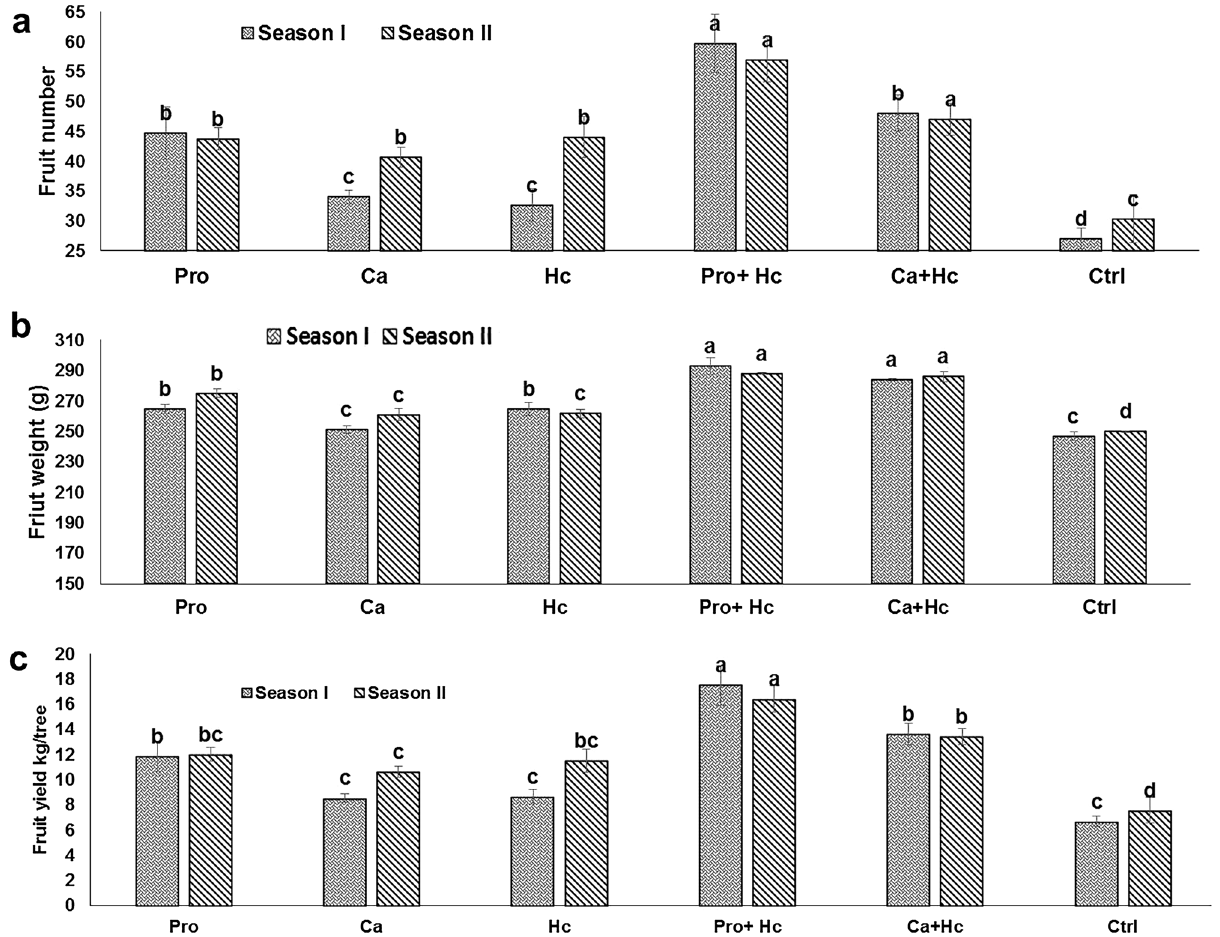
Figure 4. Effect of Proline (Pro) and Calcium (Ca) as foliar application alone or incombination with humic acid (Hc) as soil application on ( a ) fruit number, ( b ) fruit weight (g) and ( c ) yield (kg/tree) of ‘Wonderful’ pomegranate trees grown under salt stress conditions. The different letters on the bars in each column represent significant difference at p ≤ 0.05; errors bars are standerd error of three replicates. Pro: 5 mM proline alone as foliar application; Ca: 1.5% calcium as foliar application alone; Hc: 15 g humic acid as soil application alone; Pro + Hc: 5 mM porline and 15 g humic acid; Ca + Hc: 1.5% calcium and 15 g humic; Ctrl: control (non